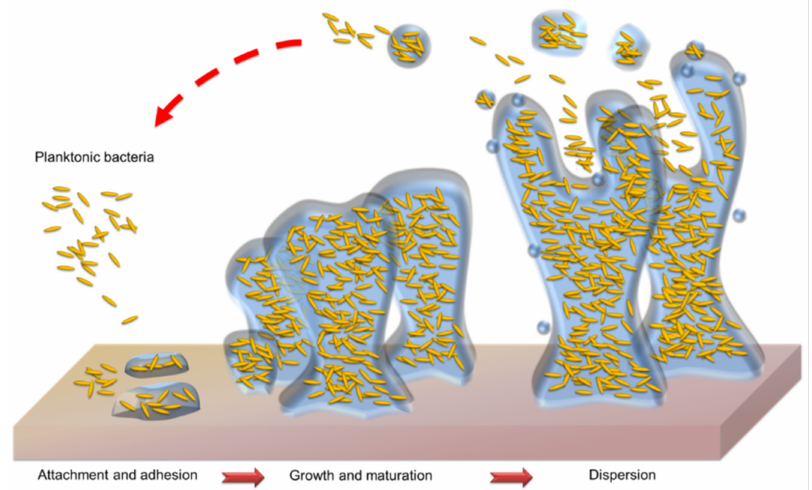
Figure 2. The process of the microbial biofilm